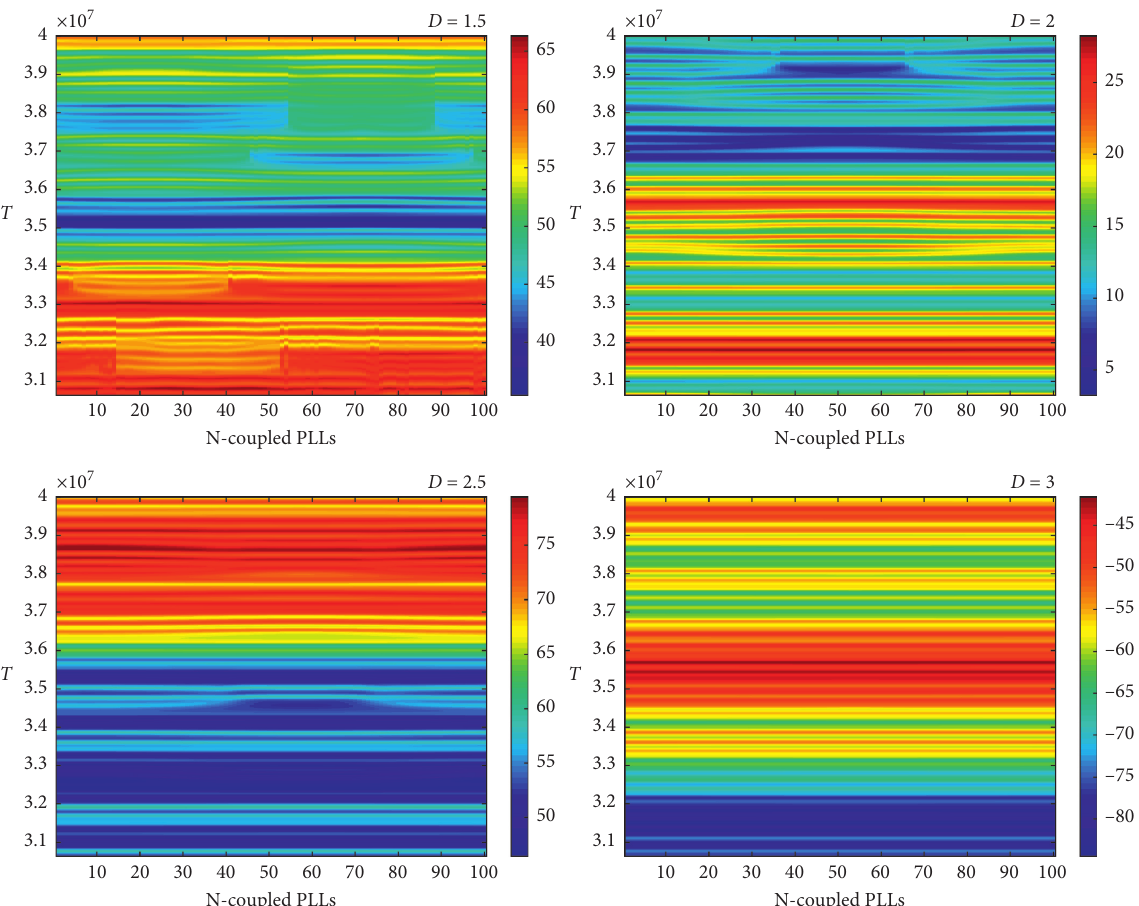
Figure 7: Spatiotemporal dynamics of the FOPLL network showing synchronisation of FOPLLs for the coupling strength 1 . 5 ≤ D ≤ 3. We have used random initial conditions between the range [ − π , π ] for all the FOPLLs. The fractional order is fixed at q � 0 . 98 and the system parameters are fixed at K � 2 . 6 ,G � 1.